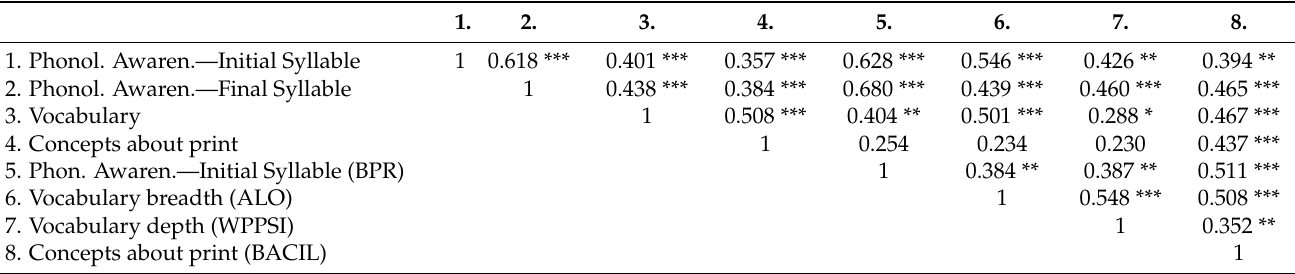
Table 5. Correlation matrix depicting correlations between all study variables (kindergarten